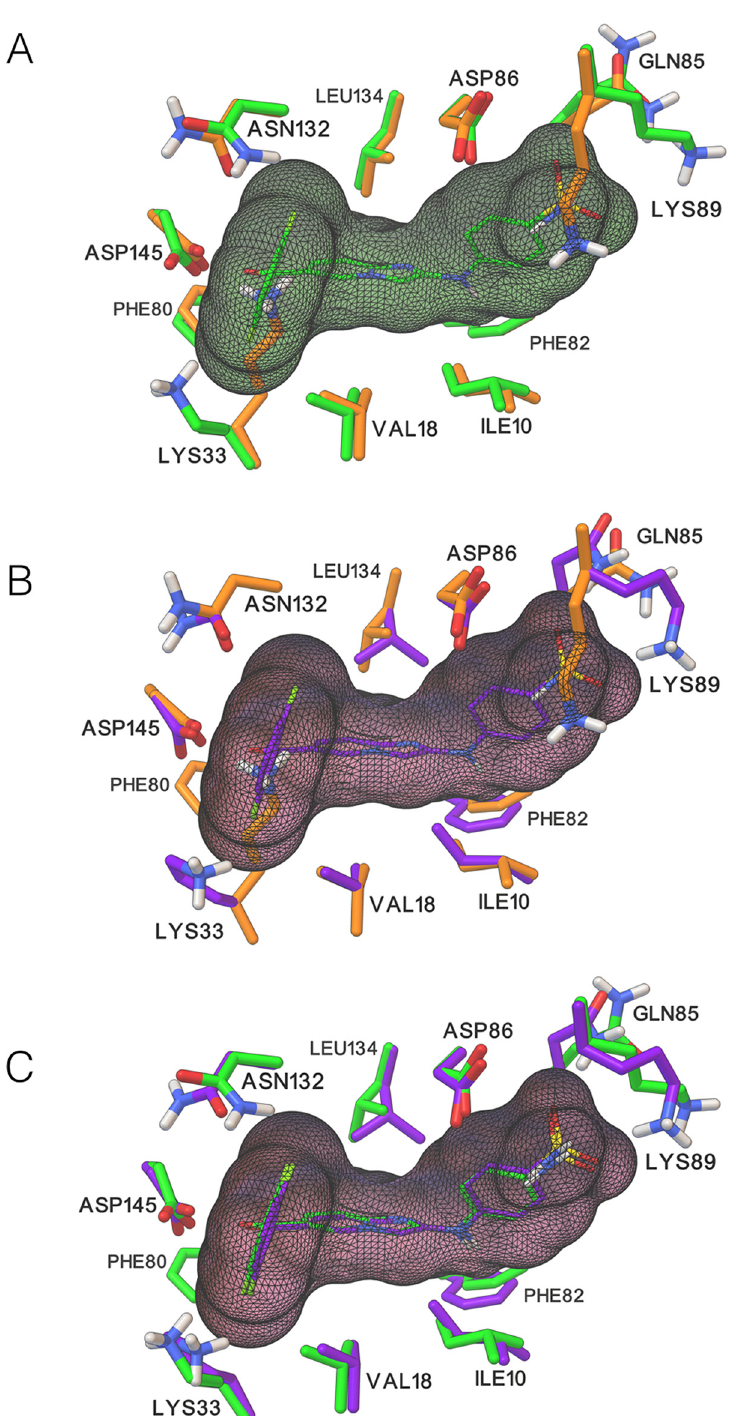
Fig 8. Comparison of side-chain conformations between apo , holo , and successfully docked solution. This figure provides a pairwise comparison of the conformations of the apo (4EK3), holo complex (1YKR), and the 1YKR ligand docked solution with the 12 flexible receptor side-chains displayed as ball-and-sticks. A) Apo vs. holo : The native bound ligand is displayed as sticks with green carbon atoms along with a partially transparent green molecular surface. The 2 lysine side-chains in the apo conformation severely overlap with the space occupied by the ligand. B) Docked vs. apo . The docked solution is shown with purple carbon atoms and partially transparent ligand molecular surface. The apo structure is shown with orange carbon atoms.